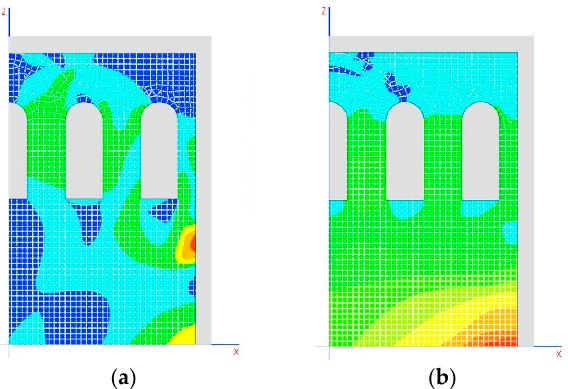
Figure 18. ( a ) Tension in the wall only to compression; ( b ) no noticeable traction stresses at any point on the wall.